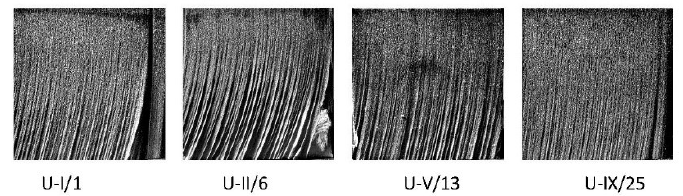
Figure 10. Photographic images of cut surfaces.